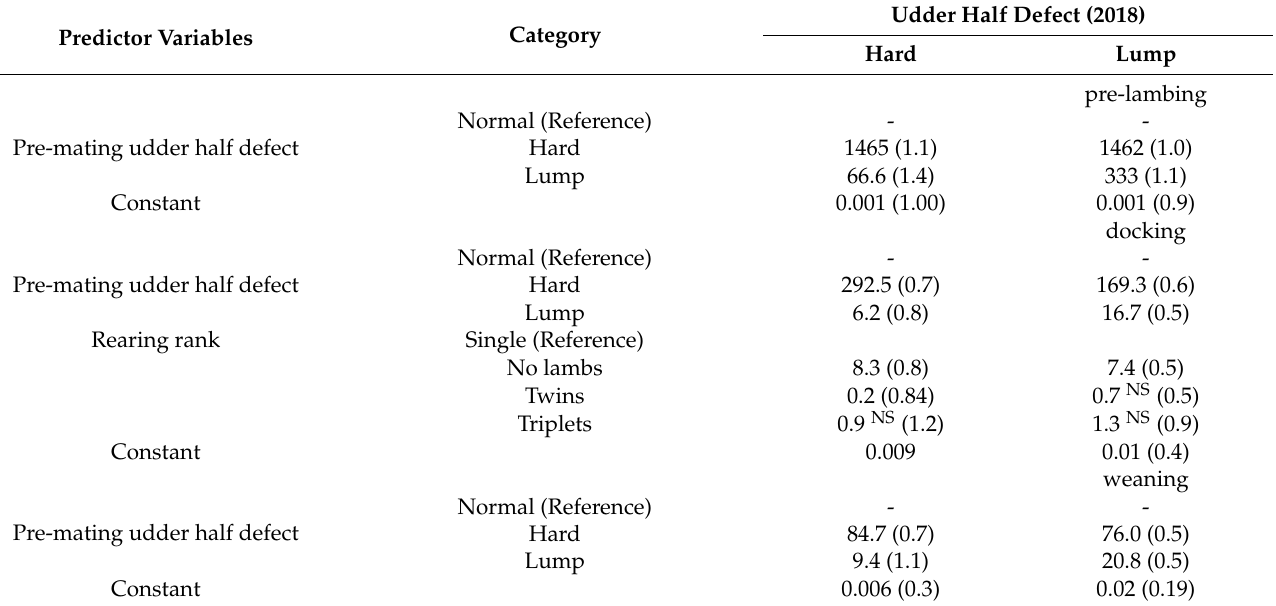
Table 2. Relative risk ratio (RRR ± standard error) of udder half defect category (normal, hard, or lump) at pre-lambing, docking, and weaning based on pre-mating udder half defect category